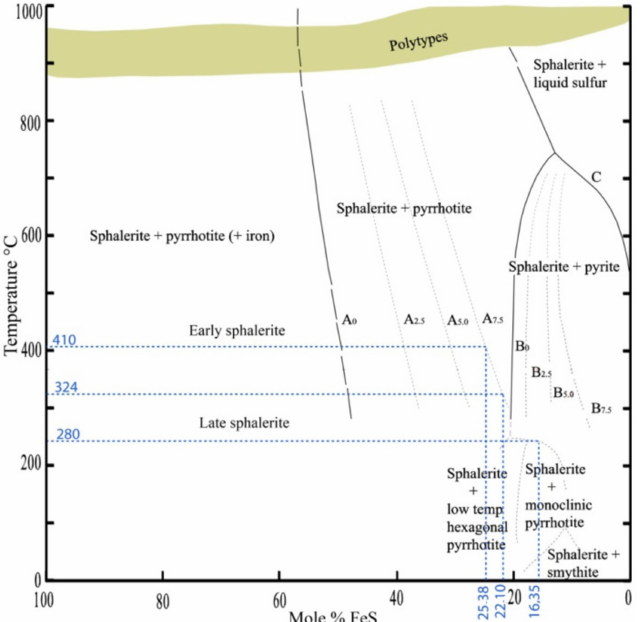
Figure 18. Estimation of the temperature conditions of NNE-A sphalerites deposition from the phase diagram of the FeS-ZnS system [64], from the temperature ( ◦ C) versus FeS (mole %)